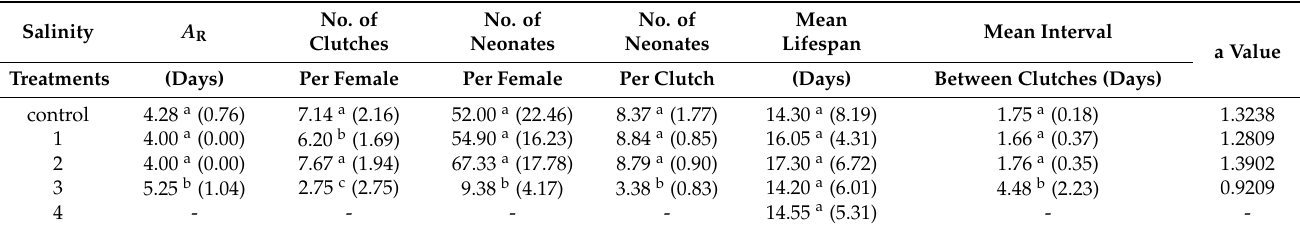
Table 1. The effect of salinity on the population increasing parameters in S. mucronate . Parameters include the mean ( ± SE) age at first reproduction (AR), lifetime number of clutches and eggs produced per female, number of eggs per clutch, lifespan, mean intervals between clutches and a value.